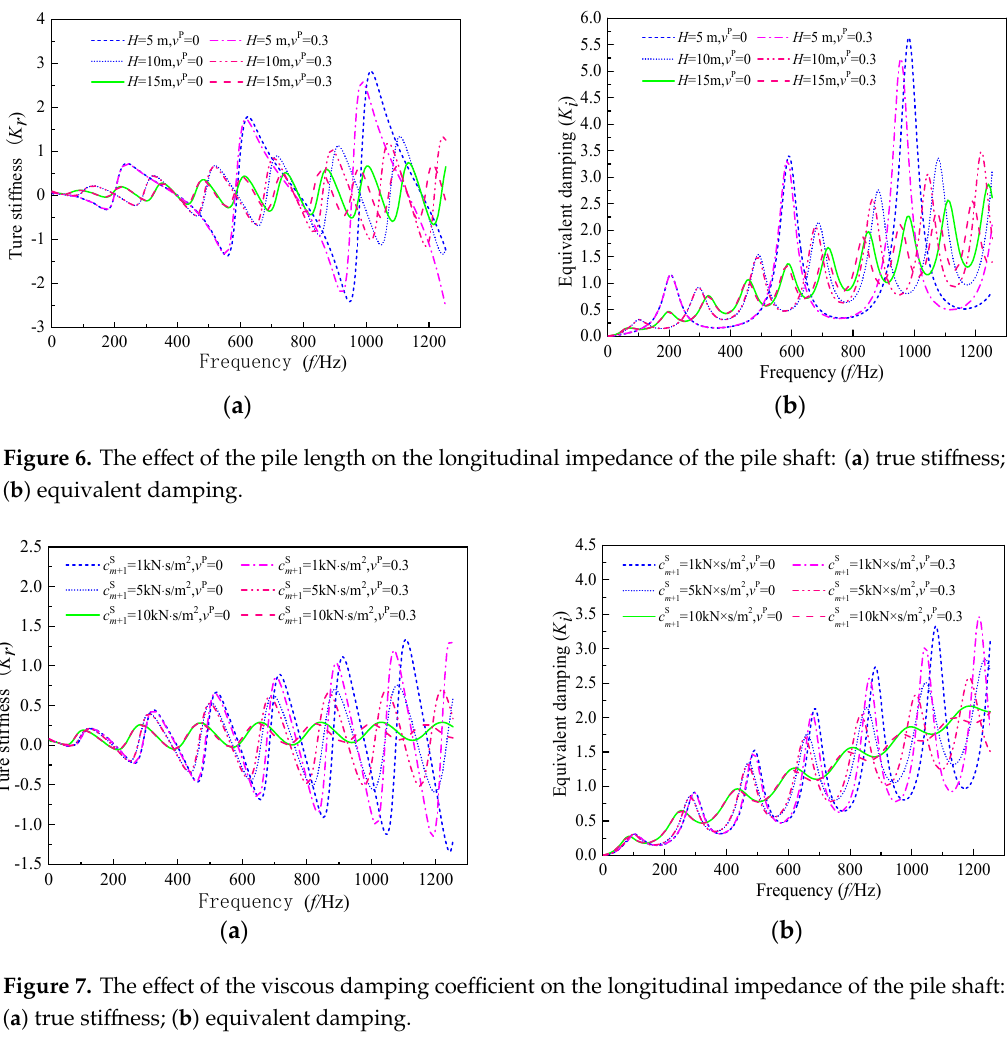
shaft: ( a ) true stiffness; ( b ) equivalent damping. ( a ) true sti ff ness; ( b ) equivalent